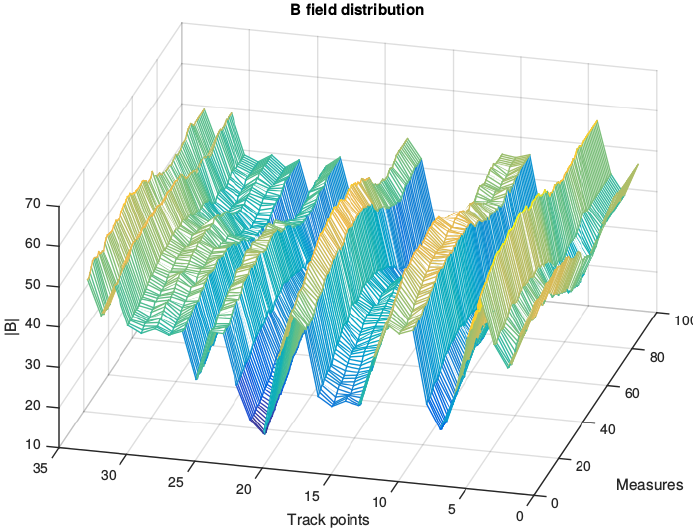
Figure 2. Distribution of the magnitude of the magnetic field along a